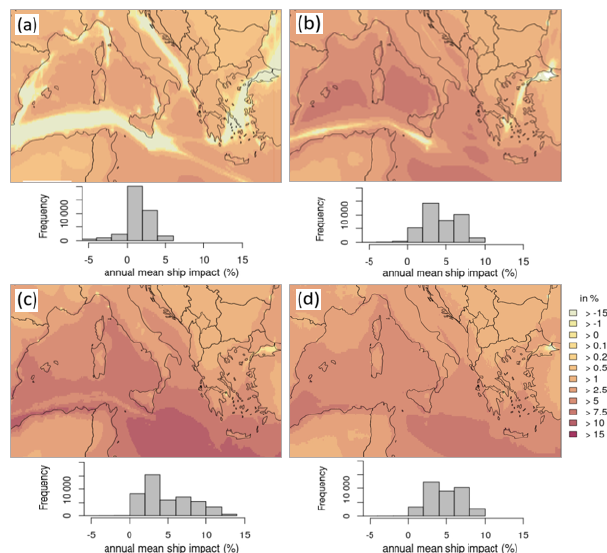
Figure 15. Annual mean dry deposition of O 3 relative potential ship impact. (a) CAMx; (b) CHIMERE; (c) CMAQ; (d) LOTOS- EUROS. Below the domain figure the respective frequency distri- bution is displayed for the annual mean O 3 dry-deposition potential ship impact, referring to the whole model